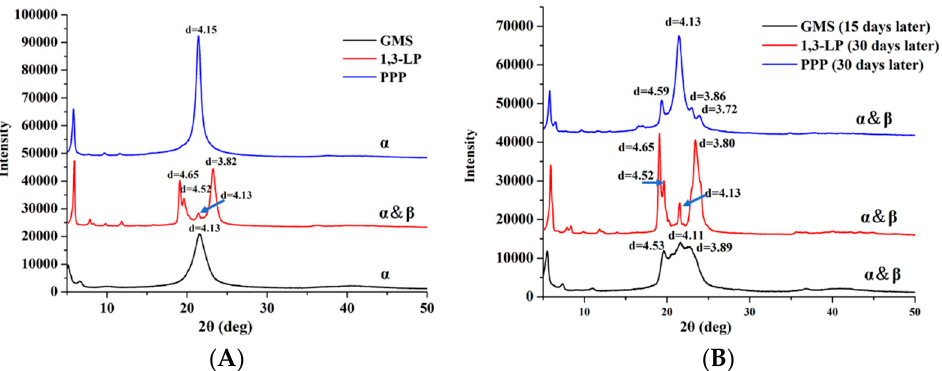
Figure 9. The X-ray powder diffraction (XRD) patterns of GMS, 1,3-LP, and PPP: ( A ) First day of preparation and ( B ) after storage at 25 °C for 15 or 30 days.